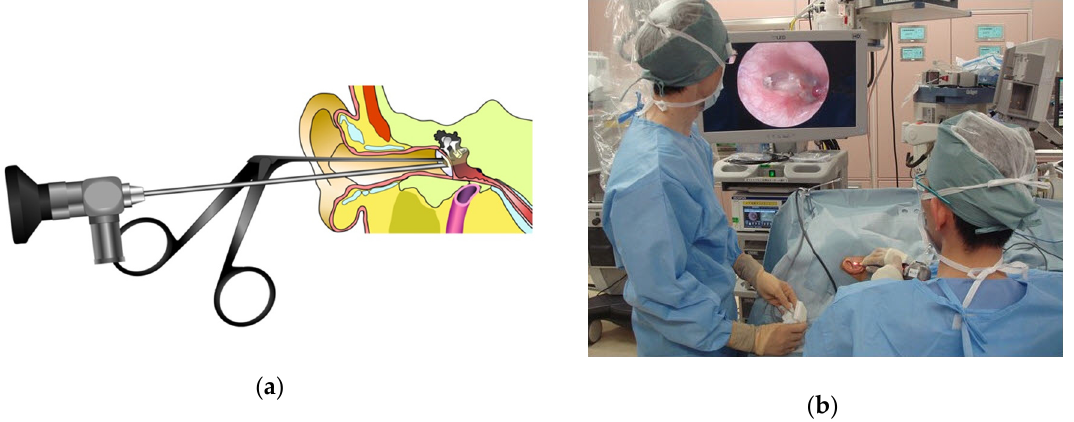
Figure 5. Transcanal endoscopic ear surgery (TEES) ( a ) Accessing the internal anatomy of the ear with an endoscope via the external auditory canal. ( b ) A surgeon performing TEES.